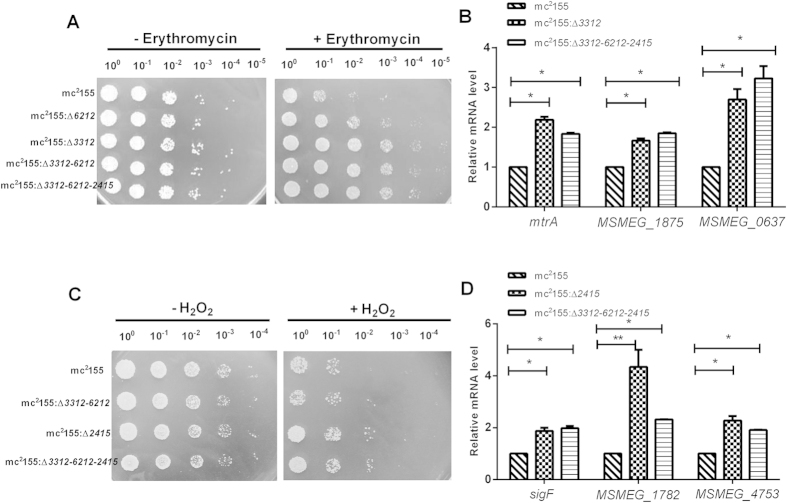
Survival of triple hemerythrin-like gene knockout mc2155:Δ3312-6212-2415 after challenge with H2O2 and erythromycin.(A) Erythromycin resistance phenotype of mc2155, mc2155:Δ3312, mc2155:Δ6212, mc2155:Δ3312-6212 and mc2155:Δ3312-6212-2415. The pictures shown are representative of three independent experiments. (B) Relative expression levels of mtrA, msmeg_1874, and msmeg_0637 in mc2155:Δ3312 and mc2155:Δ3312-6212-2415. mRNA expression levels were determined by qRT-PCR. Results are shown as the mean ± standard deviation of three replicates (*p < 0.05). (C) H2O2 resistance phenotype of mc2155, mc2155:Δ2415, mc2155:Δ3312-6212 and mc2155:Δ3312-6212-2415. The pictures shown are representative of three independent experiments. (D) Relative expression levels of sigF, msmeg_1782, and msmeg_4753 in mc2155:Δ2415 and mc2155:Δ3312-6212-2415. mRNA expression levels were determined by qRT-PCR. Results are shown as the mean ± standard deviation of three replicates (*p < 0.05, **p < 0.01).